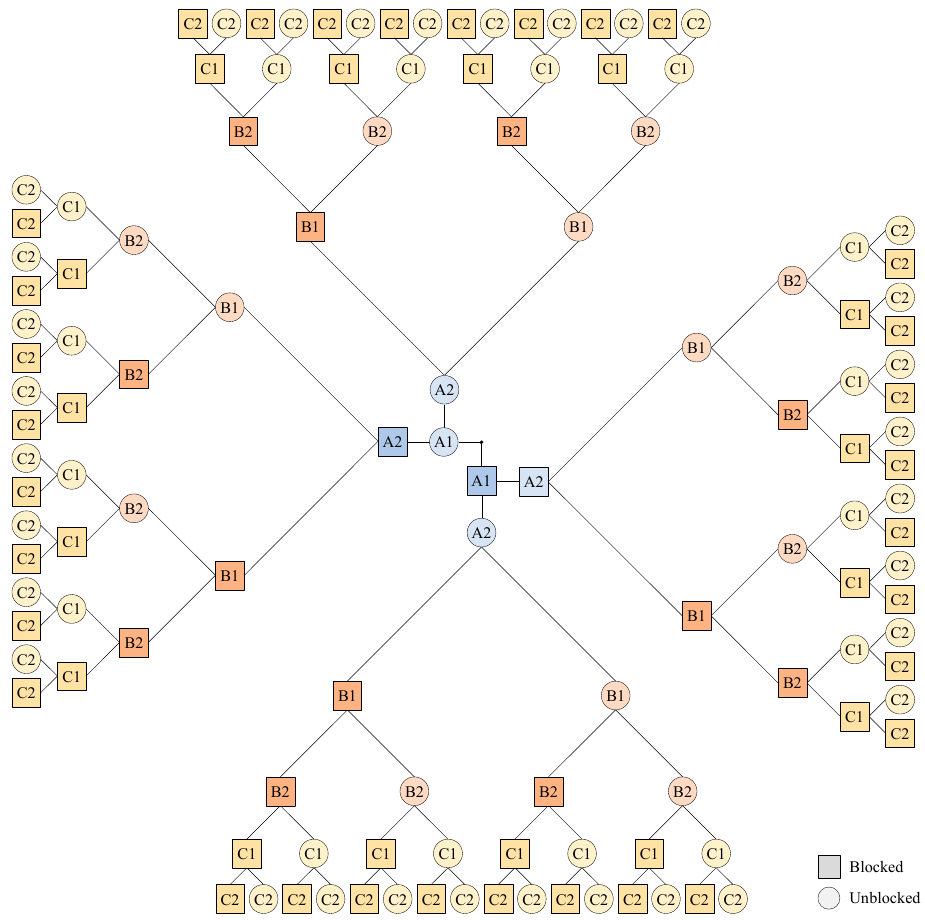
Figure 7. Classified analysis of scenario clusters.